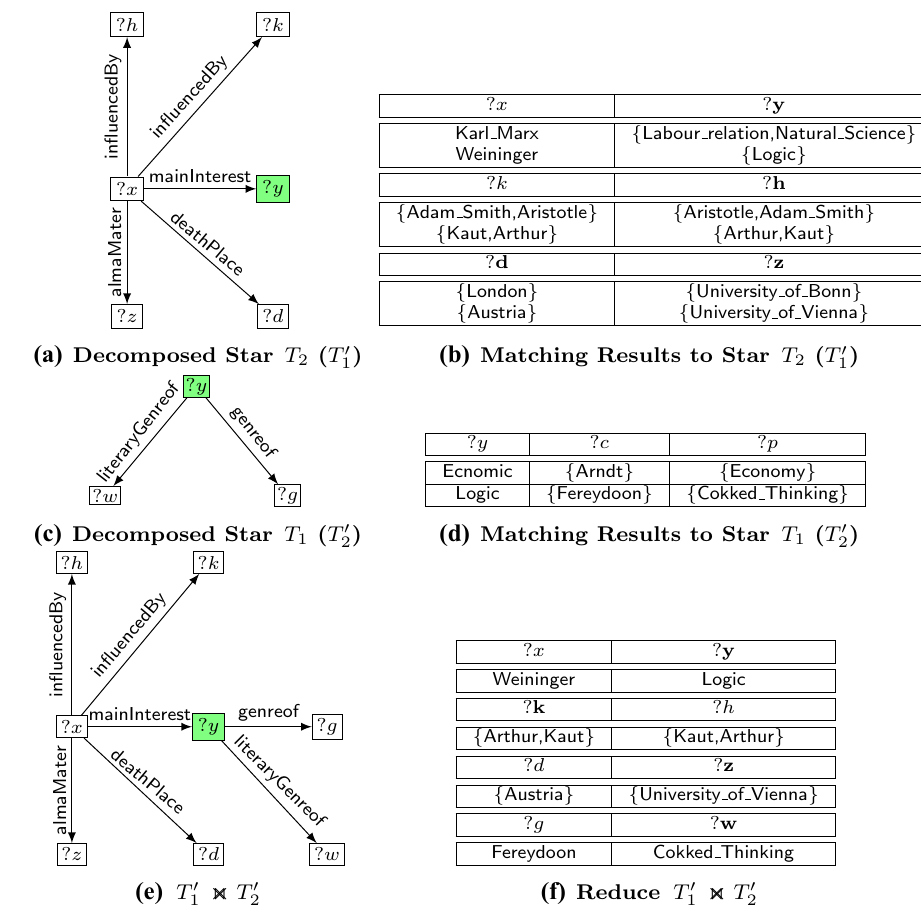
Fig. 4 Matching stars with the optimization algorithm 𝐒𝐭𝐚𝐫𝐌𝐑